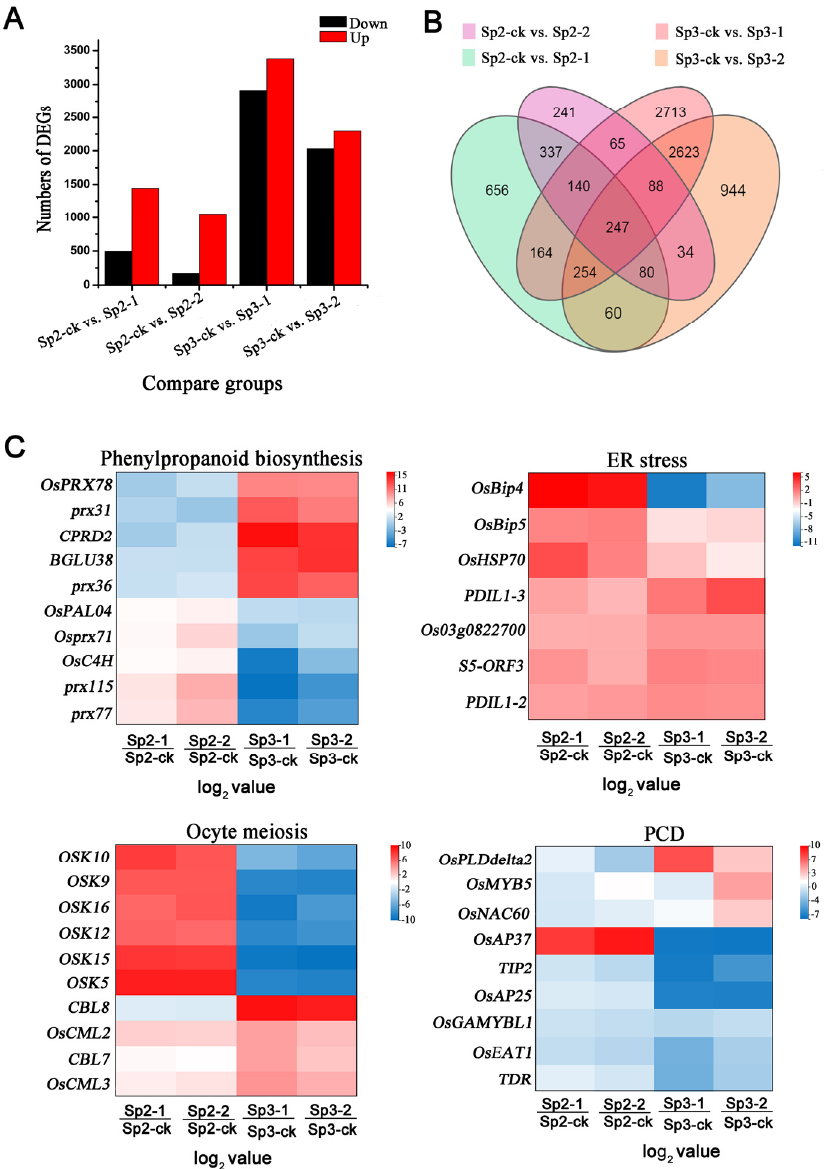
Figure 7. Transcriptome analysis of the panicles of WT (fertility) and F 1 hybrids (sterility) ( A ) Number of the up- and down-regulated DEGs at Sp2 and Sp3 stages. ( B ) The Venn diagram shows the numbers of shared and unique DEGs. ( C ) The ratio of the expression of genes selected in the DEGs. The expression level based on log2 (FPKM + 0.01) is represented by a heat map. Sp2-ck, Sp2-1 and Sp2-2 indicated the florets in length ranges of 10.2–11.5 mm of the hybrid F 1 from 04-06/14-06, 04-06/10-06, and 14-06/10-06 respectively. Sp3-ck, Sp3-1, and Sp3-2 indicated the florets one day before heading off the hybrid F 1 from 04-06/14-06, 04-06/10-06, and 14-06/10-06 respectively.